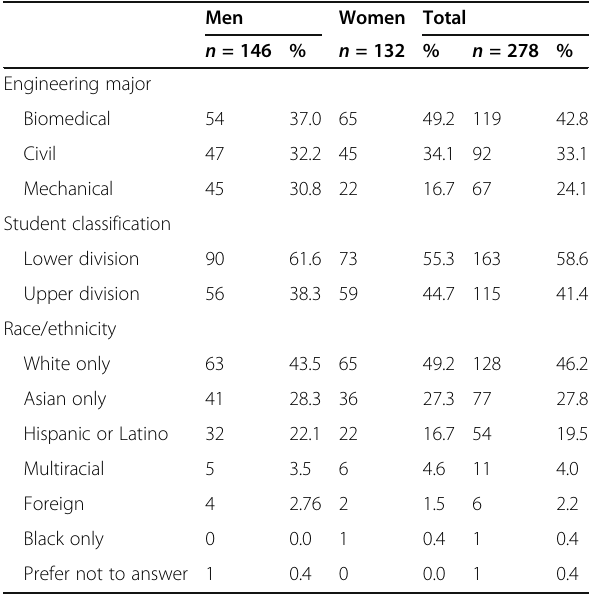
Table 1 Demographic and academic overview of the analytical sample, n =